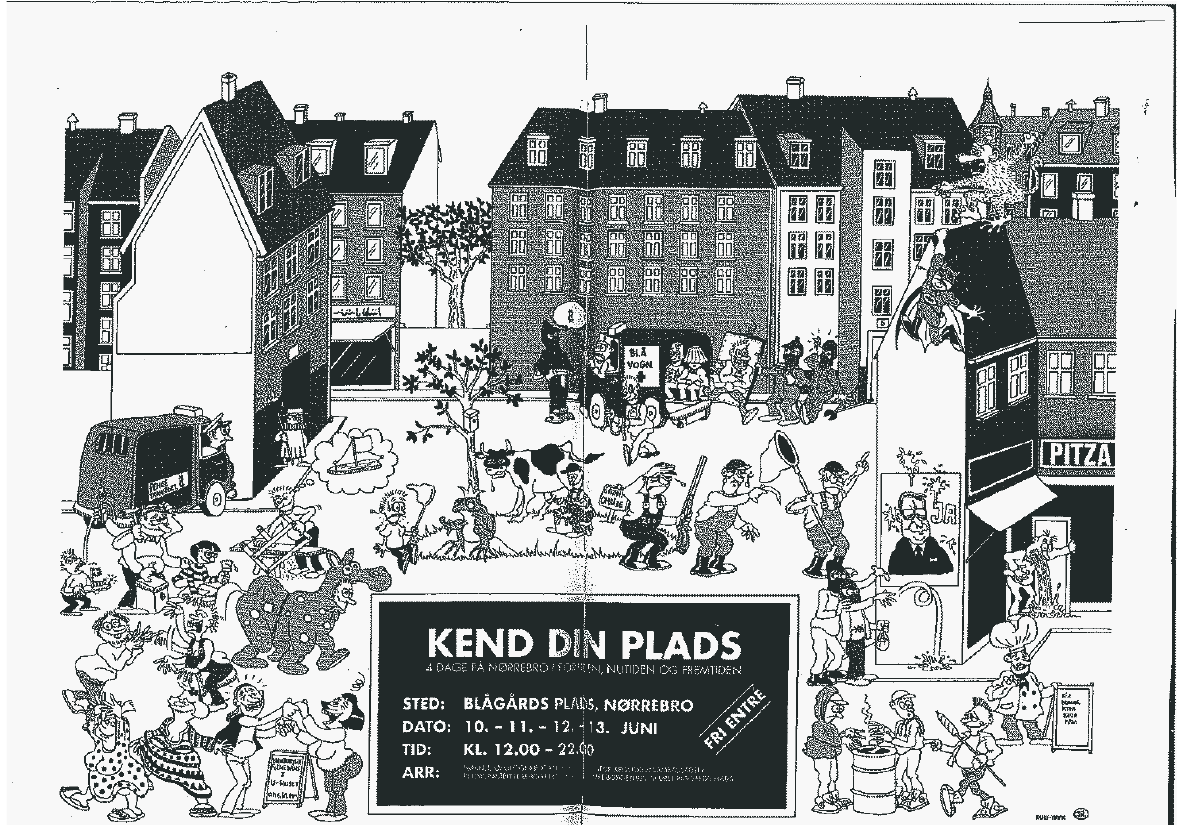
Figure 2: The poster for the "Know your place"